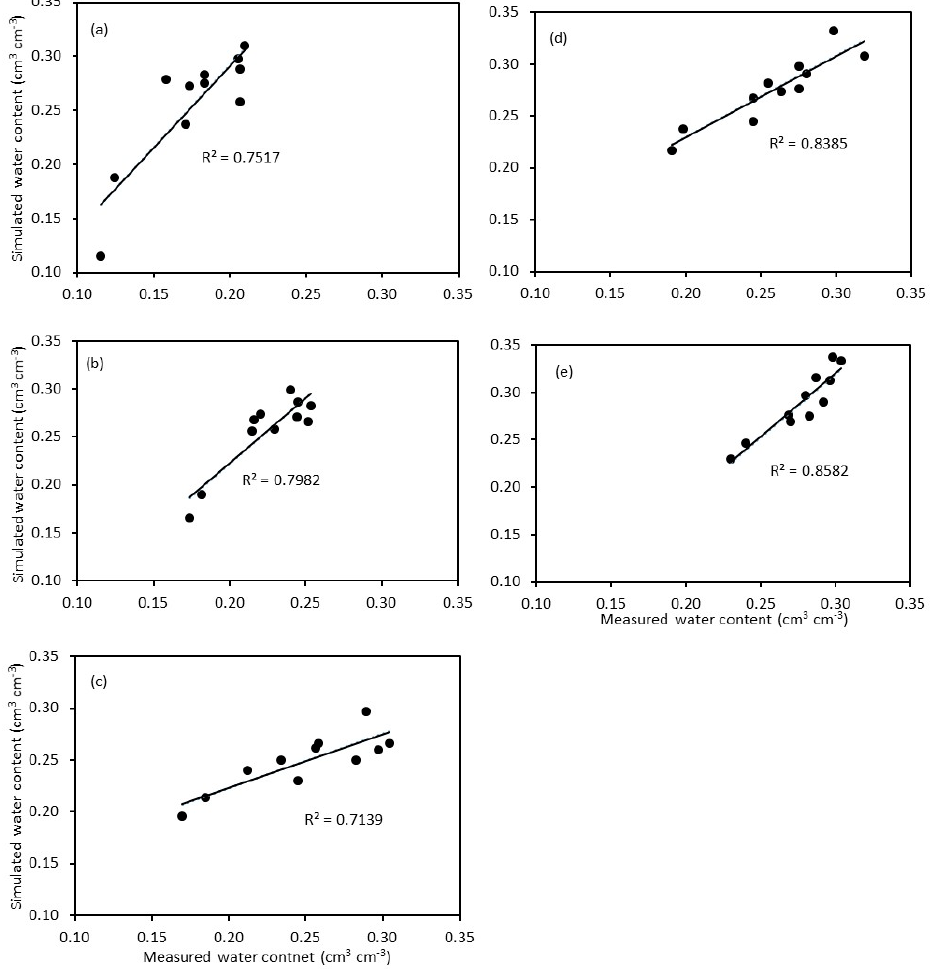
Figure 5. Measured and simulated water content for different soil depths: ( a ) 0–15 cm, ( b ) 15–30 cm, ( c ) 30–60 cm, ( d ) 60–90 cm, ( e ) 90–120 cm. ( c ) 30–60 cm, ( d ) 60–90 cm, ( e ) 90–120